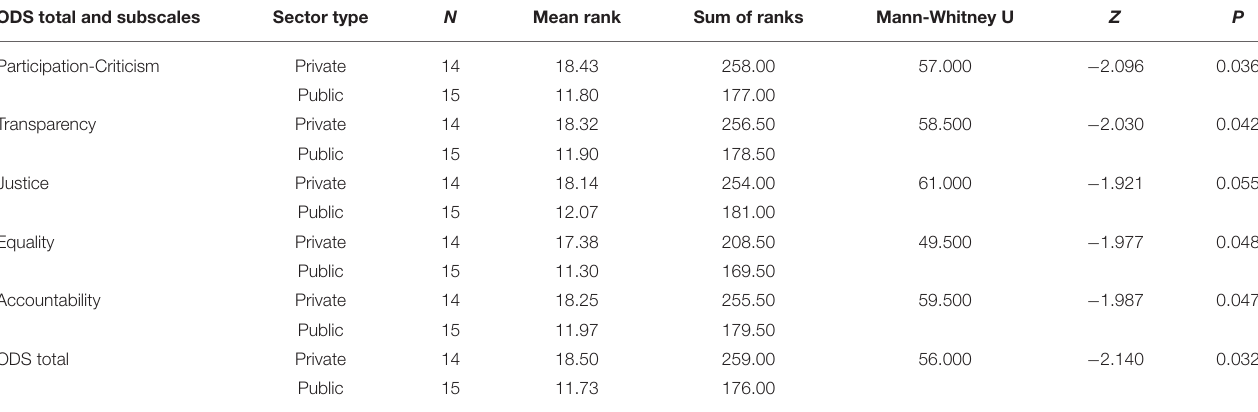
TABLE 2 | Comparison of ODS and subscale scores of private and public sector employees. ODS total and